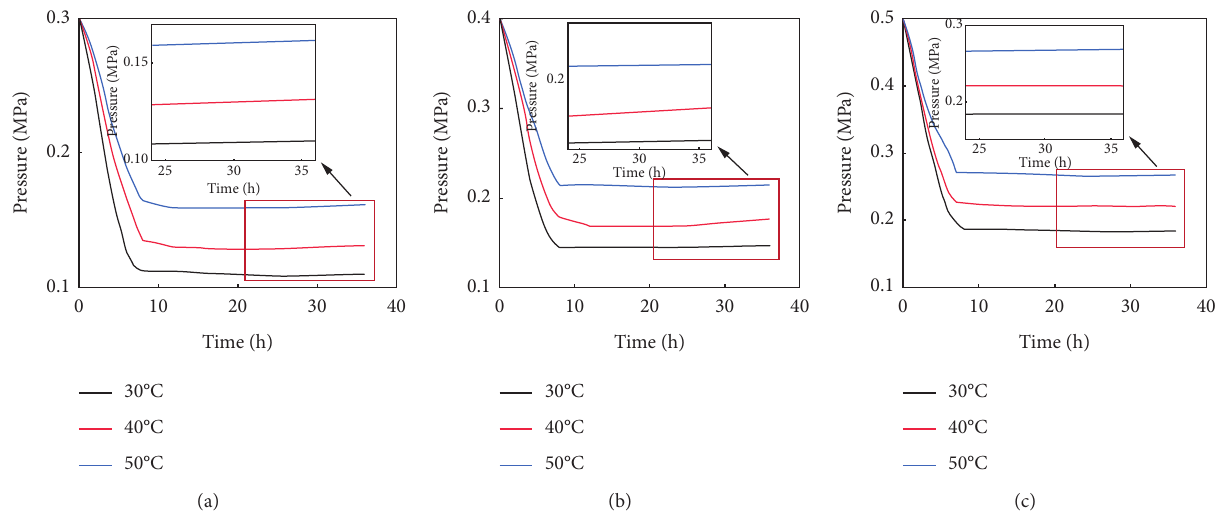
Figure 10: Pressure drop in the tube furnace vs. time at temperature varying from 30 ° C to 50 ° C at CO and (c) 0.5MPa upon CO 2